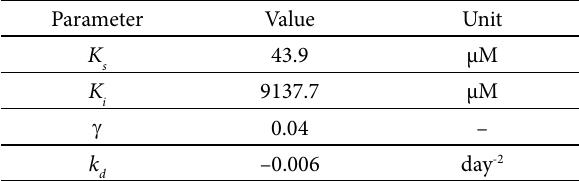
Table 7. The parameters value calculated by nonlinear regression in the second simulation case Parameter